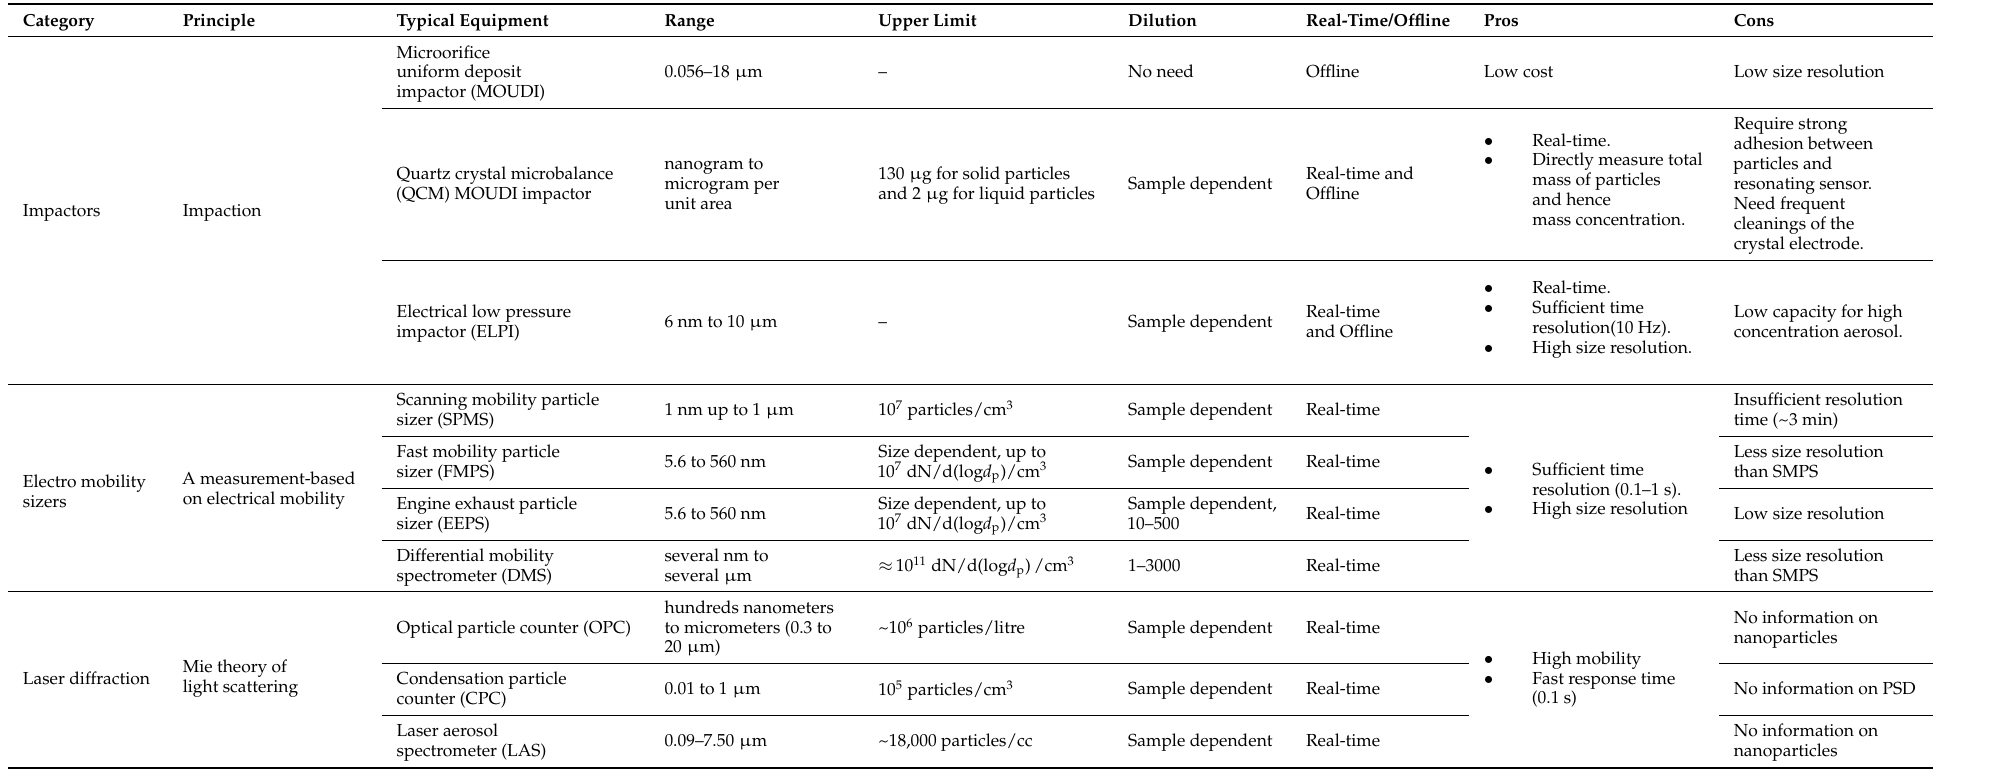
Table 1. Commonly used instruments to measure particle size and distribution of e-cigarette